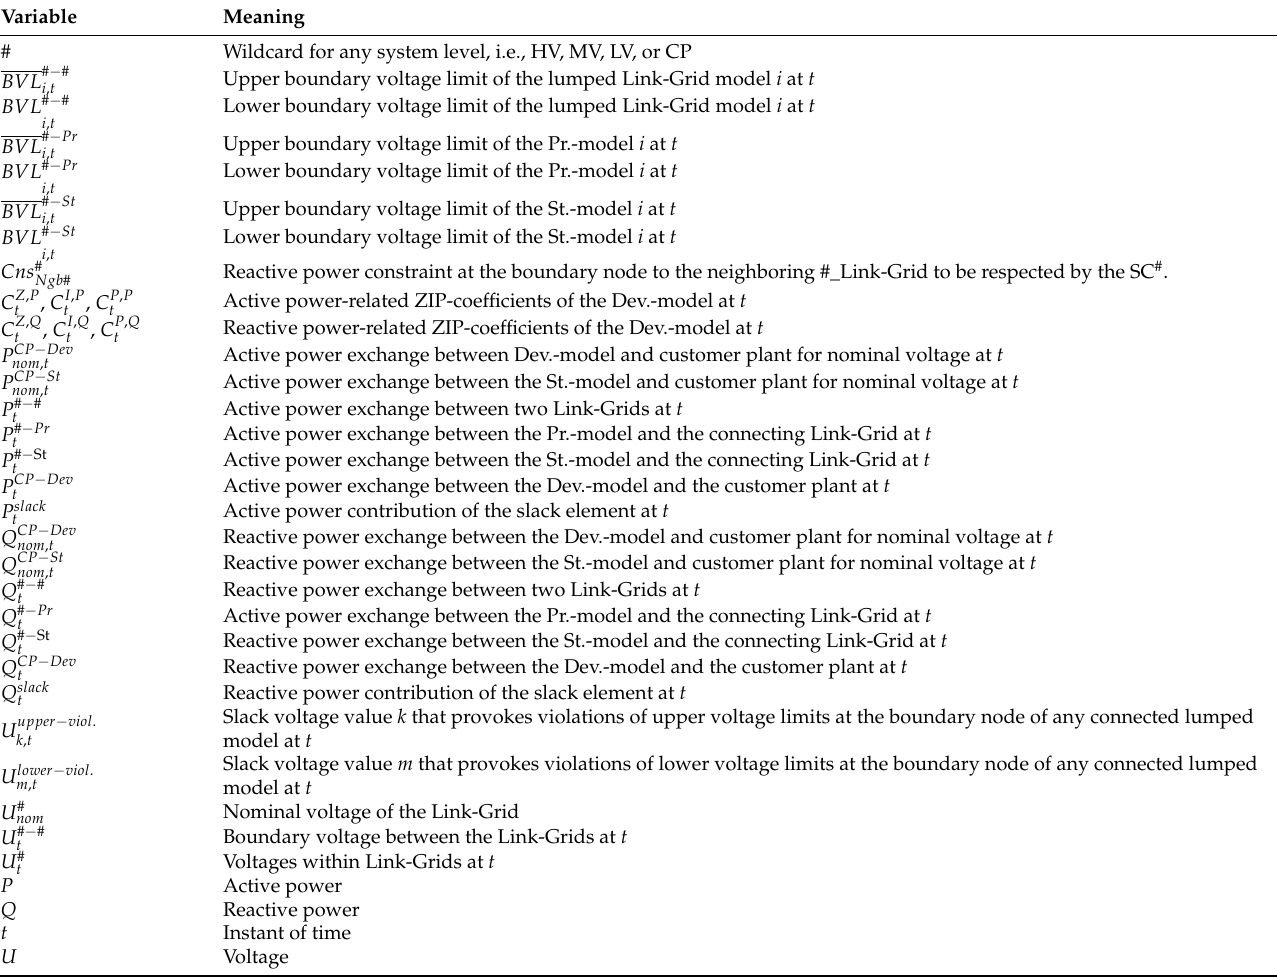
Table A2. Nomenclature of